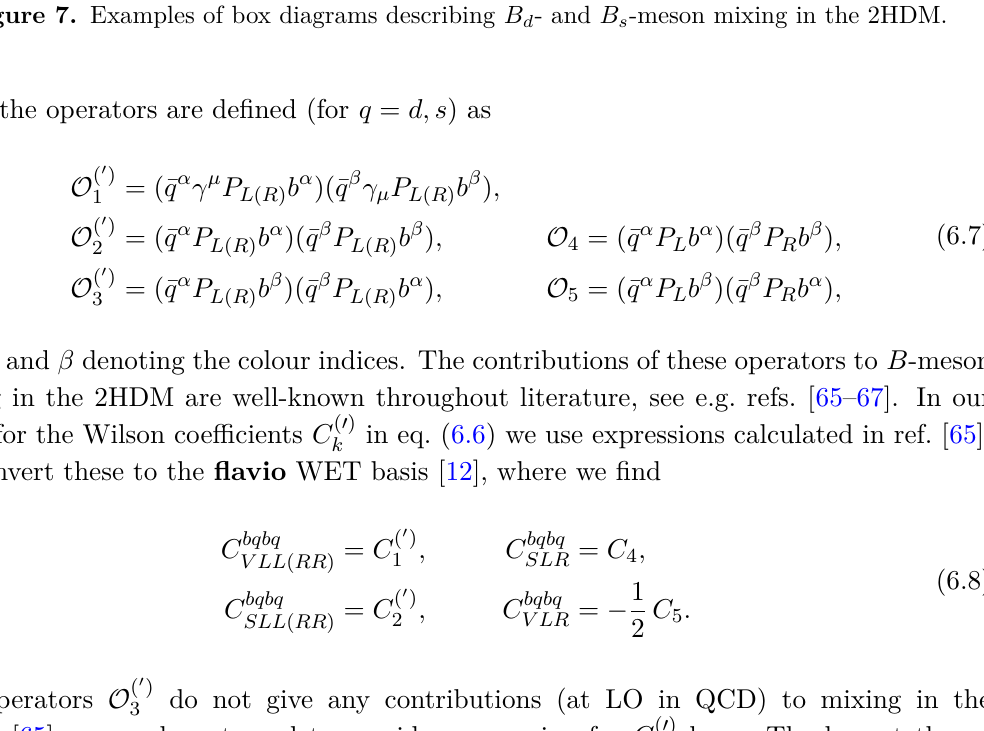
Figure 7. Examples of box diagrams describing B d - and B s -meson mixing in the 2HDM.